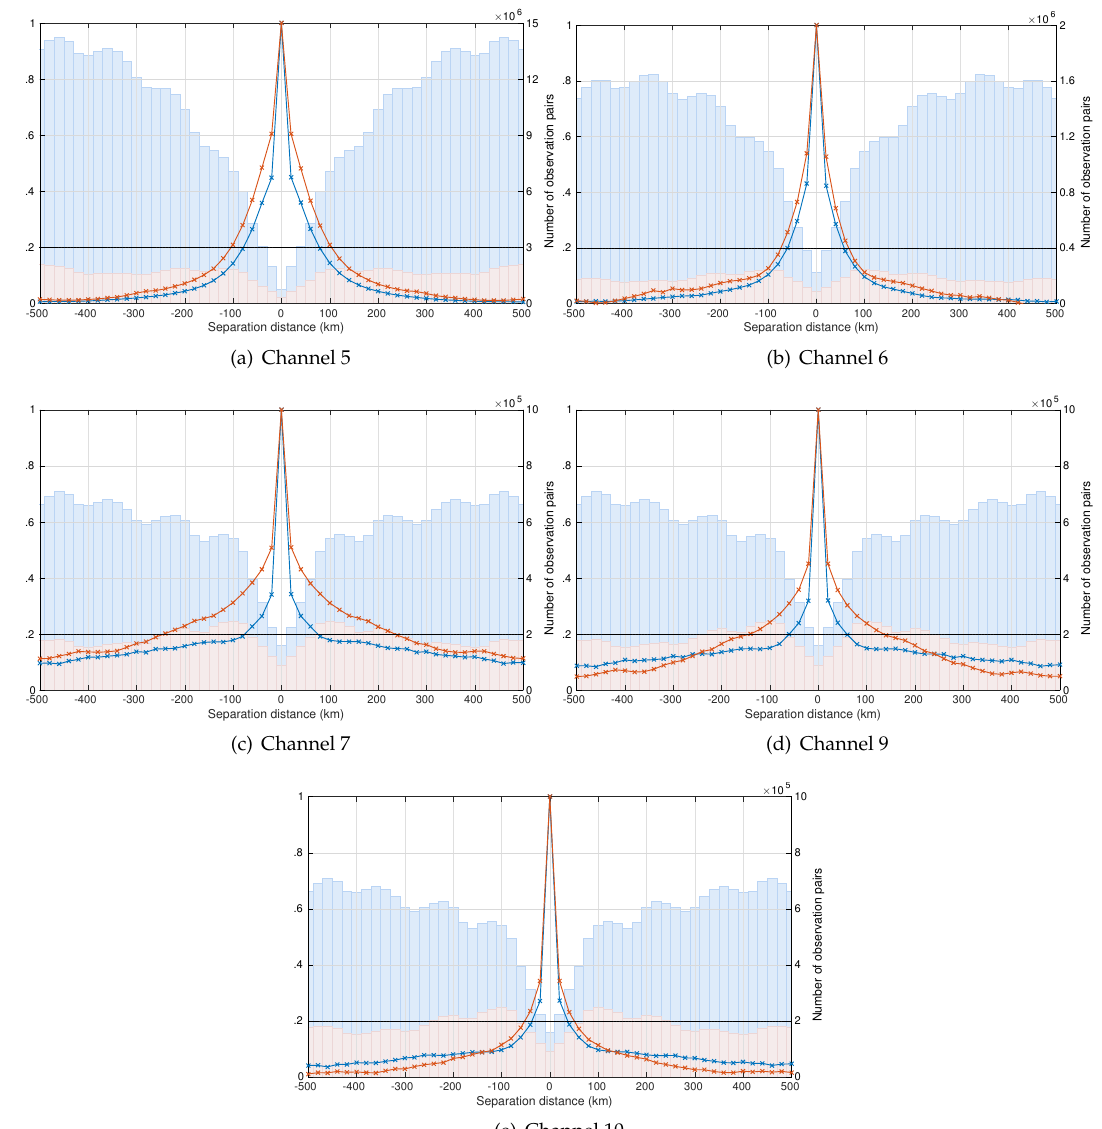
Figure 5. Estimated horizontal observation error correlation (lines) and number of observation pairs (bars) used for all observation pairs ( blue ) and sea-only observation pairs ( red ). The horizontal black line shows the level below which the observation error correlation becomes insignificant. Panel ( a ) shows channel 5; ( b ) channel 6; ( c ) channel 7; ( d ) channel 9; ( e ) channel